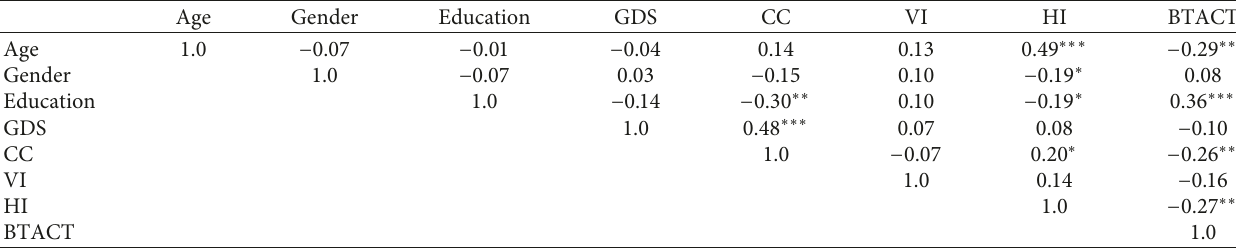
Table 1: Correlation coefficient matrix of variables included in adjusted models.